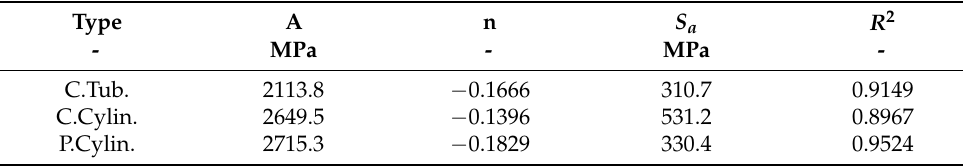
Table 2. Material parameters in the Basquin